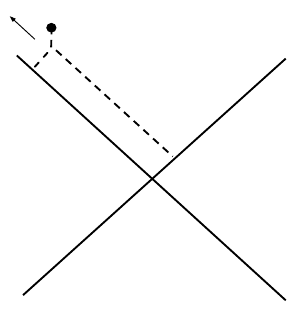
Figure 10 . Approaching a pole on @ (cid:6) corresponds not only to movement in the transverse direction towards the surface of the external brane corresponding to the pole, but also to a longitudinal movement along the brane o(cid:11) to in(cid:12)nity (in the direction of the arrow). In cases where the probe string must couple to two branes at once, approaching a pole always leads to one of the open strings stretching to in(cid:12)nite